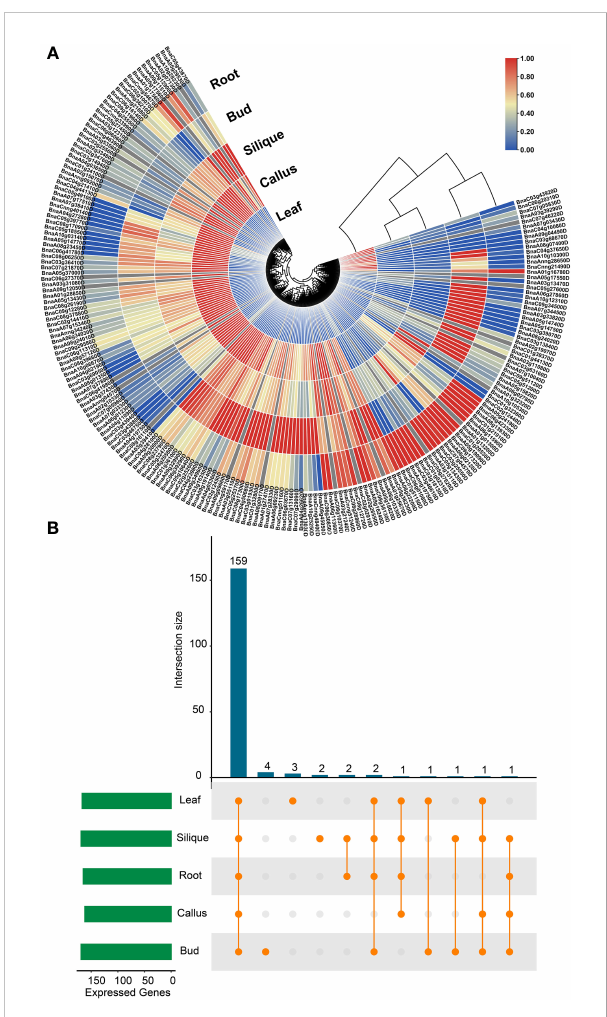
FIGURE 7 Expression pro fi les of BnUBCs across various tissues. (A) Expression data were represented by values of FPKM, and different colors showed different expression levels. (B) Number of BnUBC s expressed across various